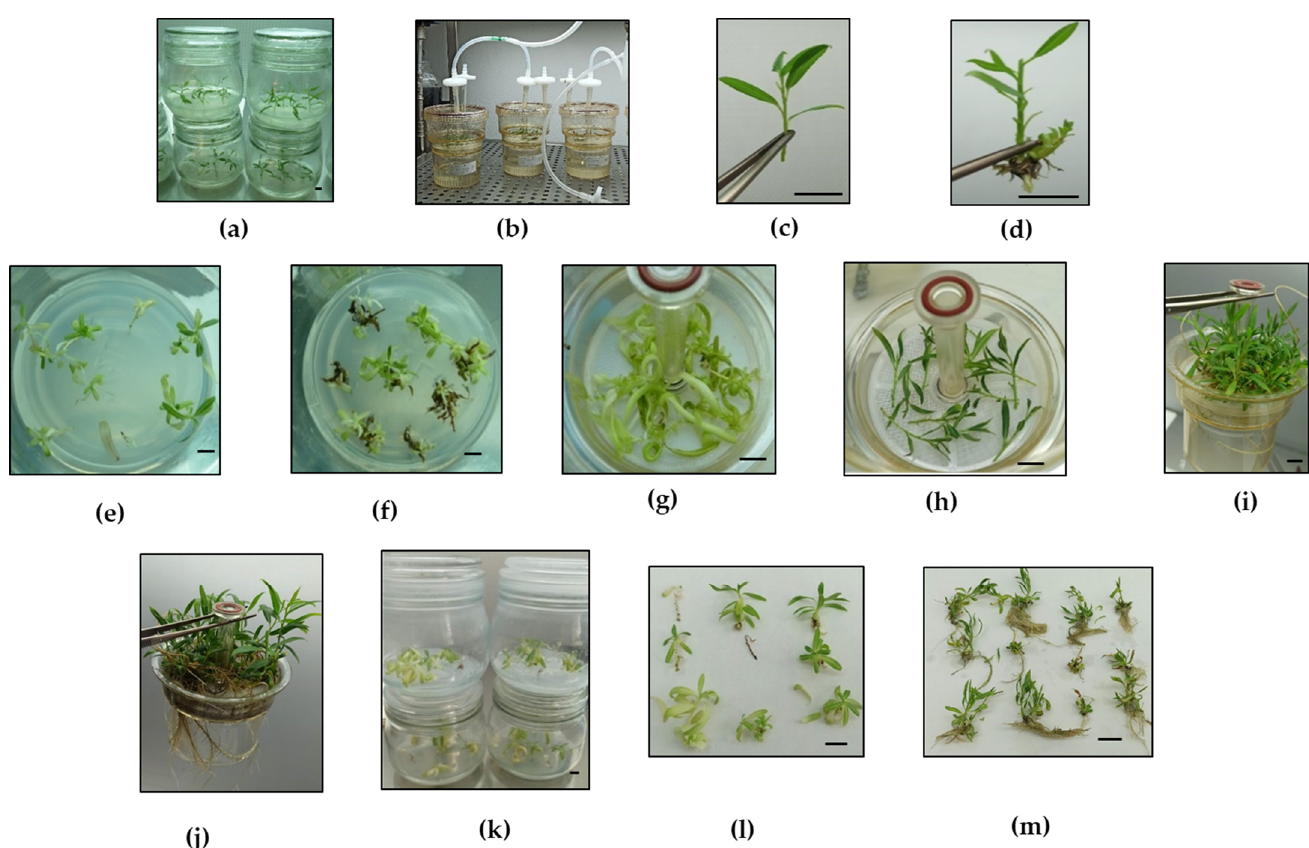
Figure 1. Micropropagation of willow in semisolid medium and bioreactors with different sucrose supplementation. ( a ) Jars used for propagation in semisolid medium. ( b ) RITA ® bioreactors used for propagation in liquid medium by temporary immersion. ( c , d ) Apical ( c ) and basal ( d ) sections of willow used as initial explants. ( e , f ) Apical ( e ) and basal ( f ) sections of willow cultured in glass jars without sucrose in standard conditions. ( g ) Apical sections of willow cultured in RITA ® vessels without sucrose and with 3 immersions/day in standard conditions. ( h – j ) Apical segments at time zero ( h ) and after 8 weeks of cultivation under PAM conditions and 6 immersions/day in RITA ® vessels without sucrose ( i ) or with 3% sucrose ( j ). ( k – m ) Apical sections cultured in jars under high light intensity without sucrose ( k , l ) or with 3% sucrose ( m ). Bars 10 mm.